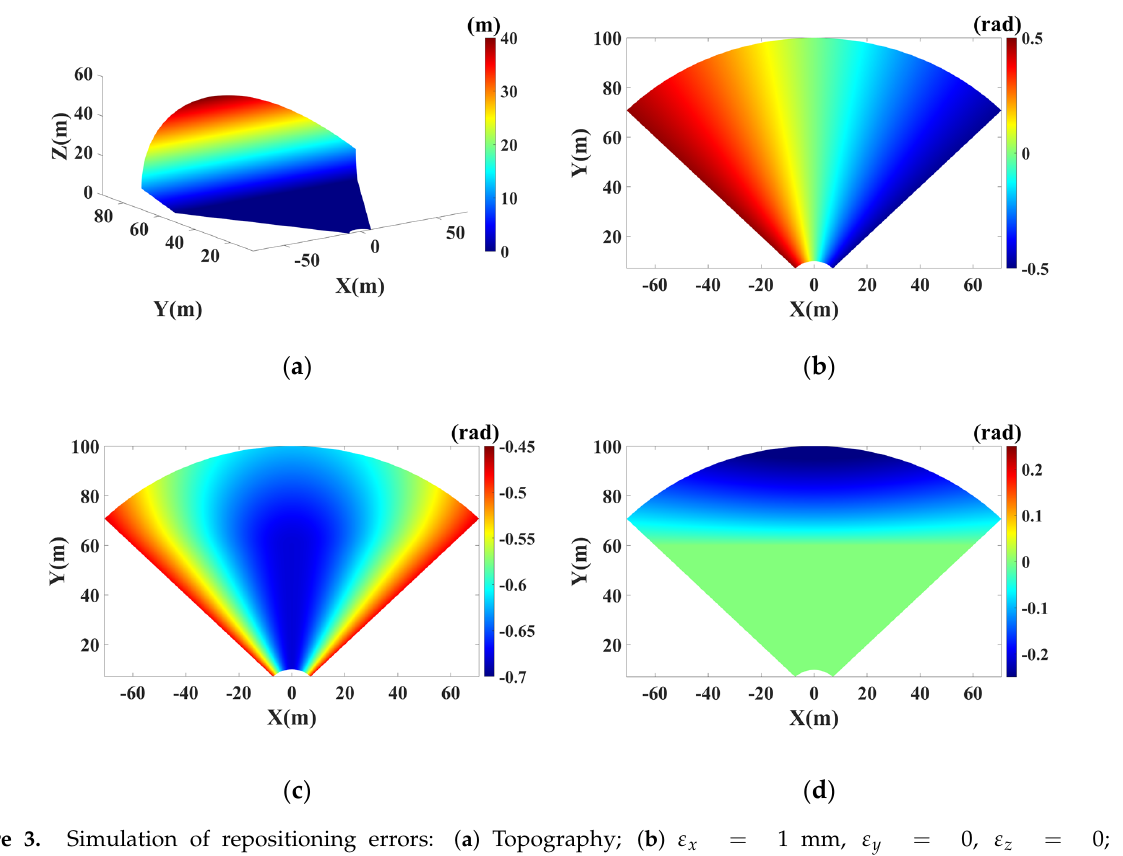
Figure 3. Simulation of repositioning errors: ( a ) Topography; ( b ) ε x = 1 mm, ε y = 0, ε z = 0; ( c ) ε x = 0, ε y = 1 mm, ε z = 0; ( d ) ε x = 0, ε y = 0, ε z = 1